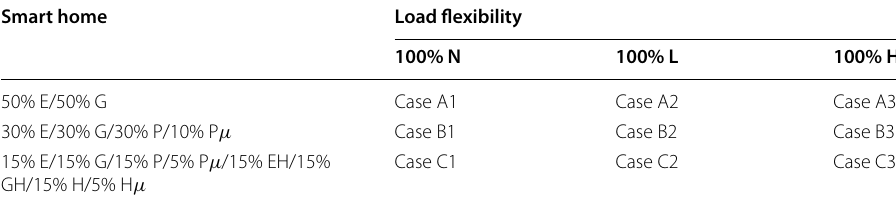
Columns: % load flexibility. Rows: % smart home configuration